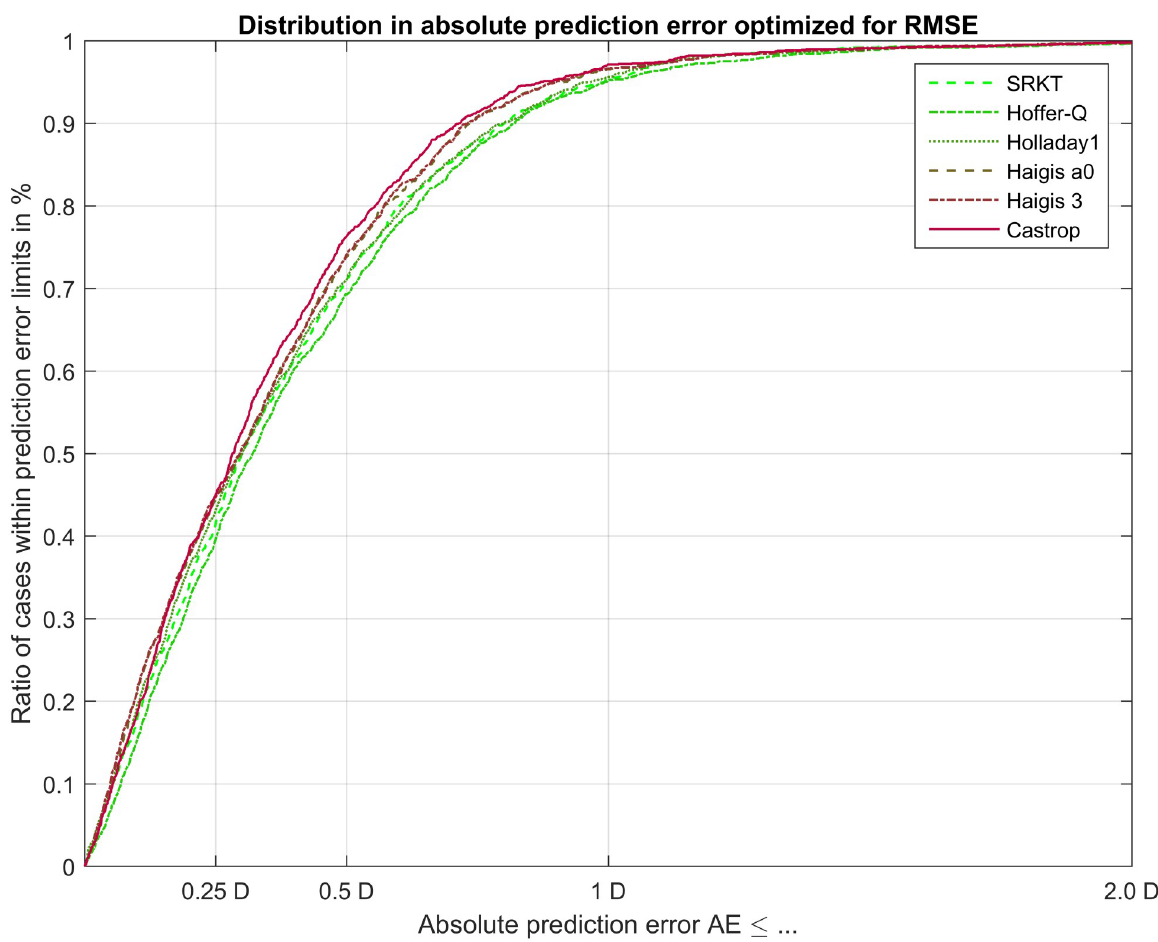
Fig 3. Performance of formula outcome in terms of absolute prediction error absPE. Formula constants have been optimized on the training dataset (N = 1017) and cross-validated on the test set (N = 435). The lines indicate the number of cases within the limits of absolute prediction error for the 6 different formulae under test, the closer the lines to 1 the more cases within limits. The ticks on the x axis indicate the typical thresholds of ± 0.25, ± 0.5, ± 1.0 dpt as found in most publications. The plot indicates that between the limits of around 0.3 to 0.8 dpt of absolute prediction error the performance of the formulae under test show some differences, where the Castrop formula (solid line in red) appears to have a better performance compared to the Hoffer-Q formula (dashdotted line in dark green).